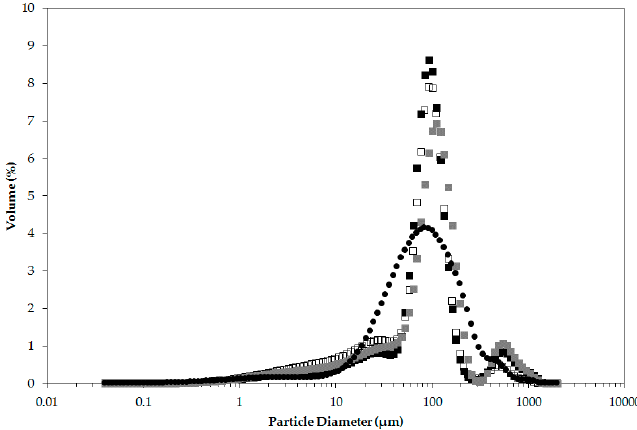
Figure 4. Emulsion droplet diameter volume size distribution of o/w emulsions stabilised with 8% milled waste coffee Pickering particles and sunflower oil as the oil phase (46%) acquired after 1 day ( (cid:4) ), 6 weeks ( (cid:3) ), and 12 weeks ( (cid:4) ) of storage at 25 ◦ C, is presented alongside the size distribution of the particles ( ) Data presented is the mean distribution of three independent emulsion samples.